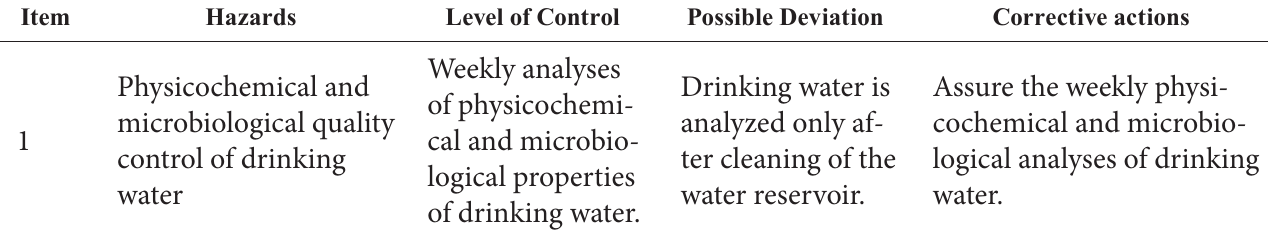
TABLE I - P otential hazards identified during the HACCP analysis of the water purification system